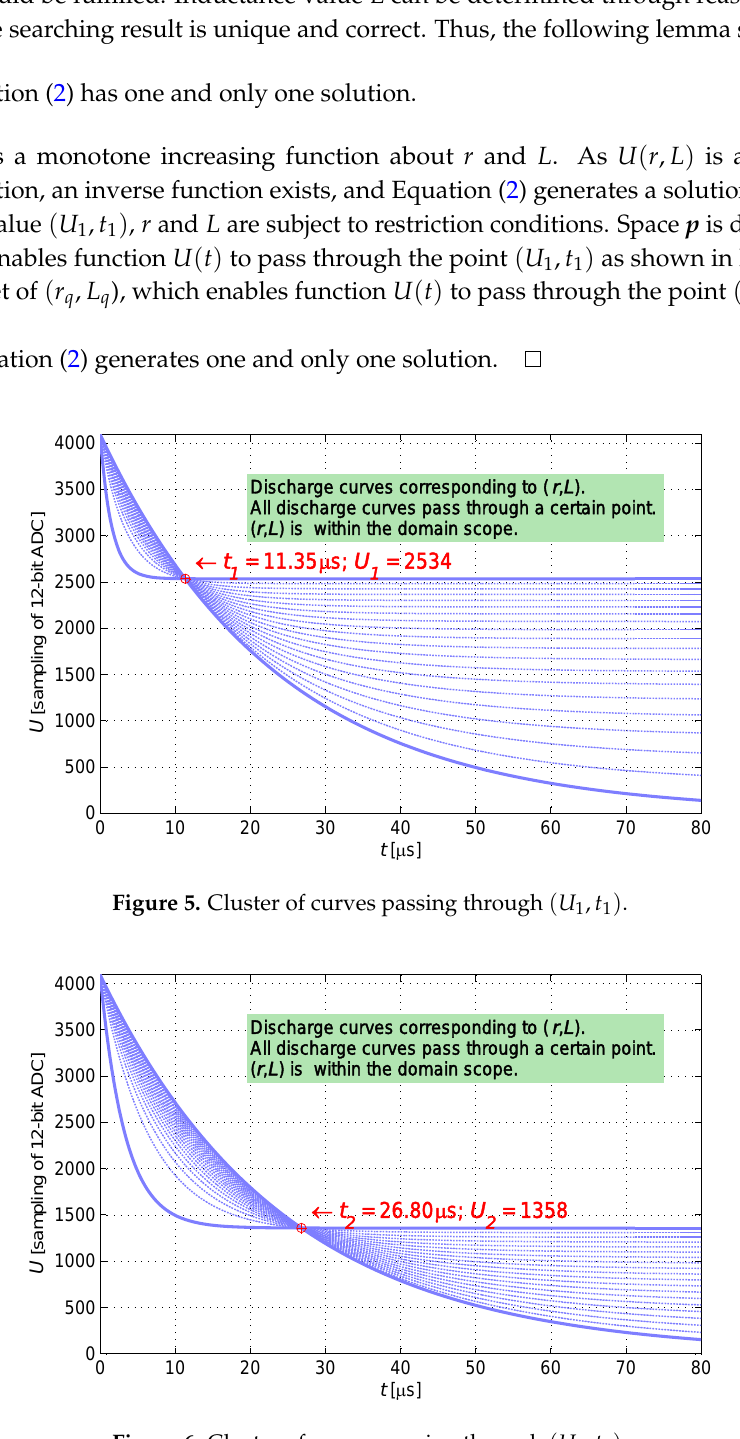
Figure 6. Cluster of curves passing through ( U 2 , t 2 )